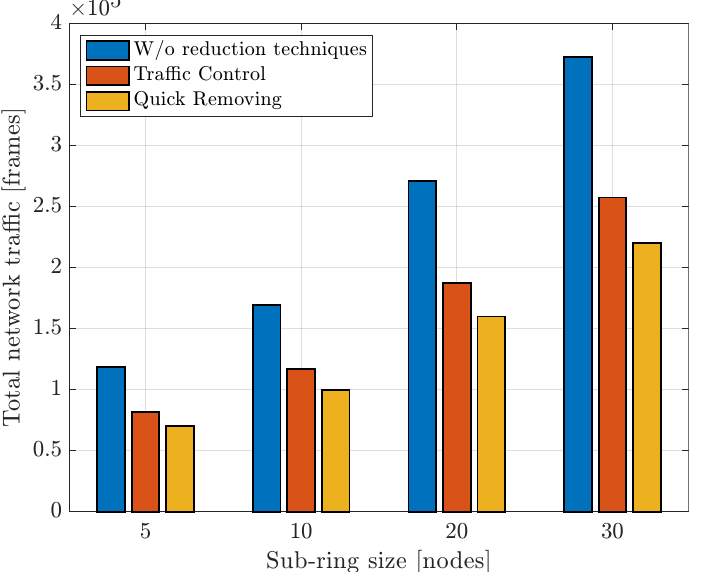
Figure 10. Traffic-reduction performance against different sub-ring sizes in the proposed